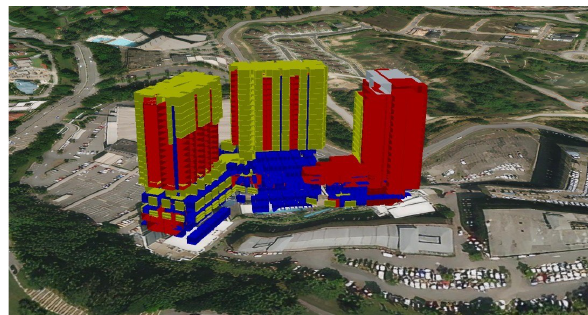
Figure 6 . Another converted scheme 13161 in CityGML via Strata ADE, tiled in 3D tiles and visualized in